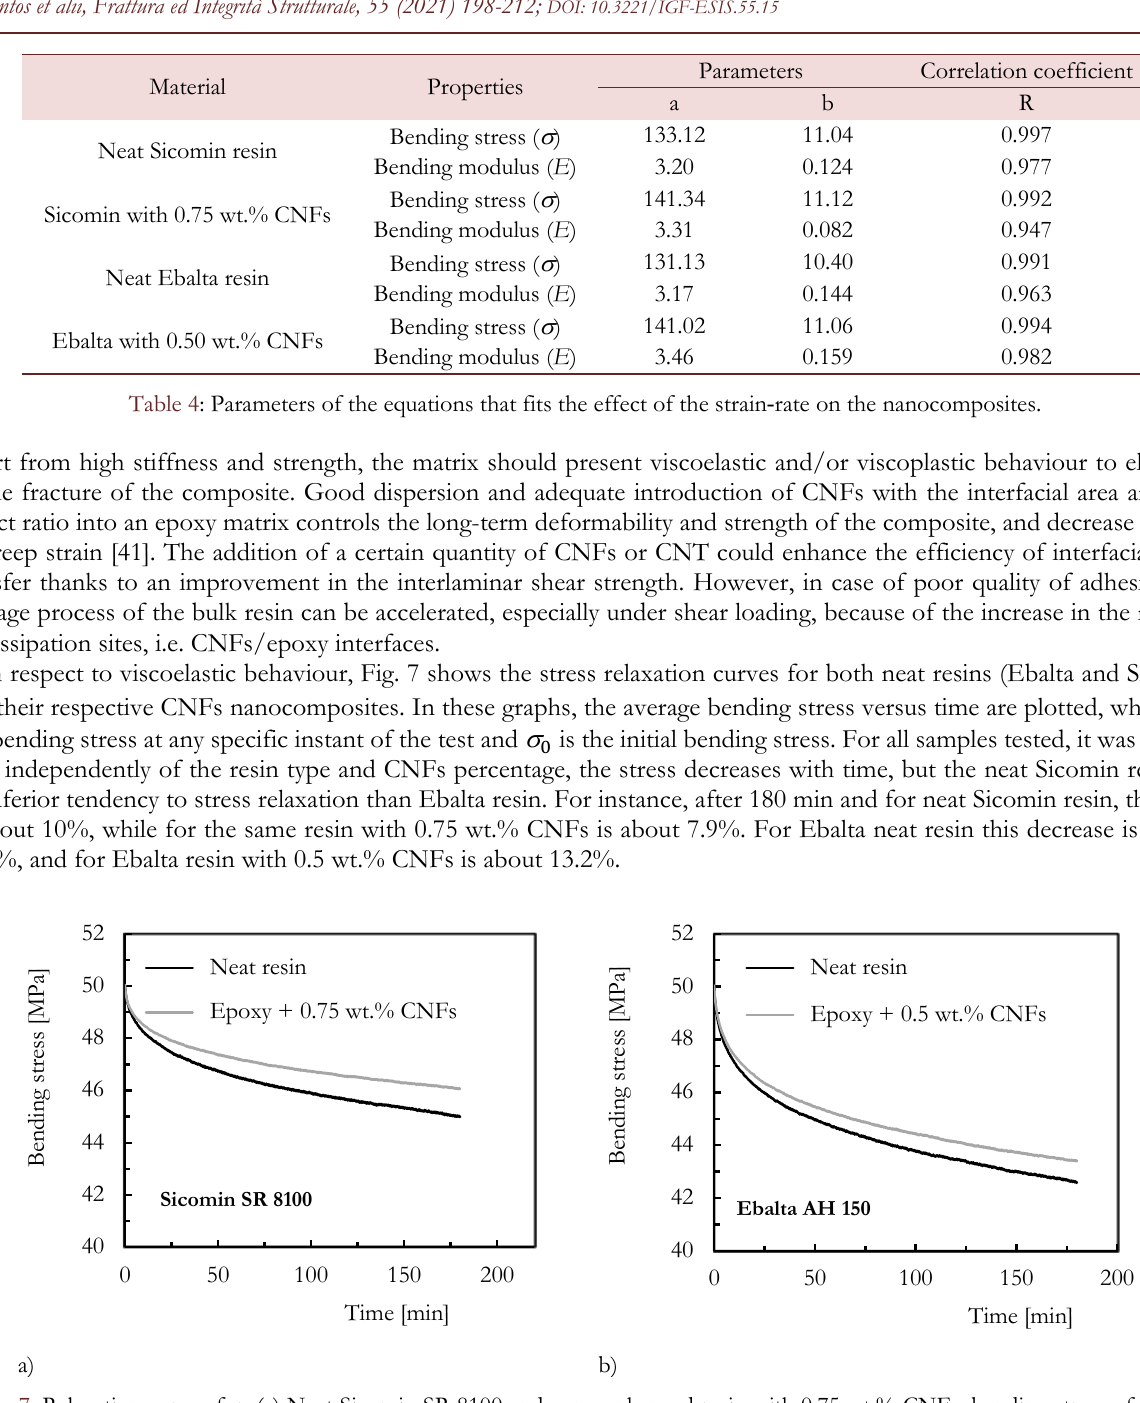
Figure 7: Relaxation curves for: (a) Neat Sicomin SR 8100 and nano enhanced resin with 0.75 wt.% CNFs, bending stress of 50 MPa; (b) Neat Ebalta AH 150 and nano enhanced resin with 0.5 wt.% de CNFs, bending stress of 50